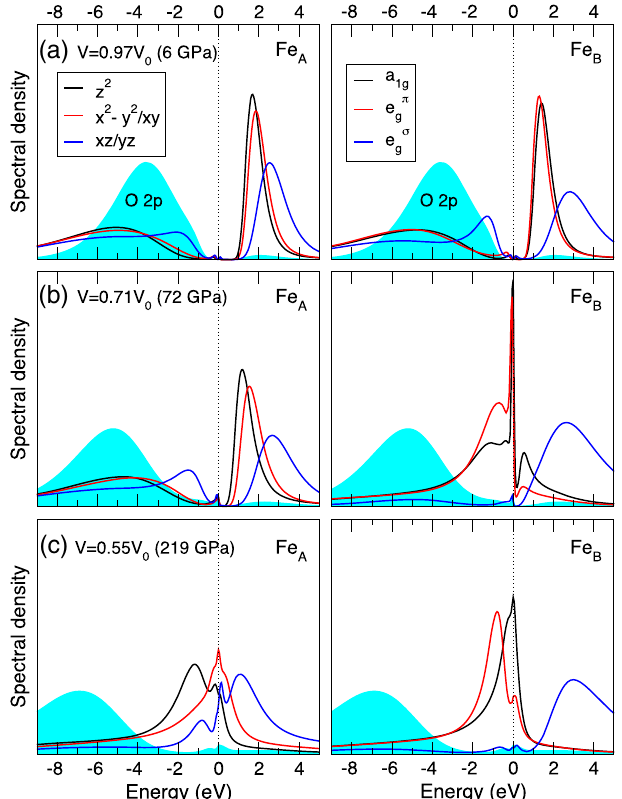
FIG. 3. Spectral function for paramagnetic DPv Fe 2 O 3 calcu- lated by DFT þ DMFT at temperature T ¼ 390 K and various lattice volumes, based on crystal structure parameters taken from the x-ray diffraction results at approximately 54 GPa. Fe 3 d (black, red, and blue curves) and O 2 p (blue-shaded area) orbitals are shown relative to the Fermi energy ( E F ¼ 0 ). DFT þ DMFT results reveal the existence of a site-selective Mott phase at V ¼ 0 . 71 V 3 d electrons of only half of the Fe sites 0 (b), in which the (right: B sites) are metallic, while the other Fe (left: A sites) remain insulating. For V ¼ 0 . 97 V 0 (6 GPa), we obtain a conven- tional Mott insulating phase in which both the Fe A and B sublattices are insulating (a). Under a high pressure of approx- imately 219 GPa ( 0 . 55 V 0 ), DFT þ DMFT give a metallic solution for both the Fe A and B sites (c).